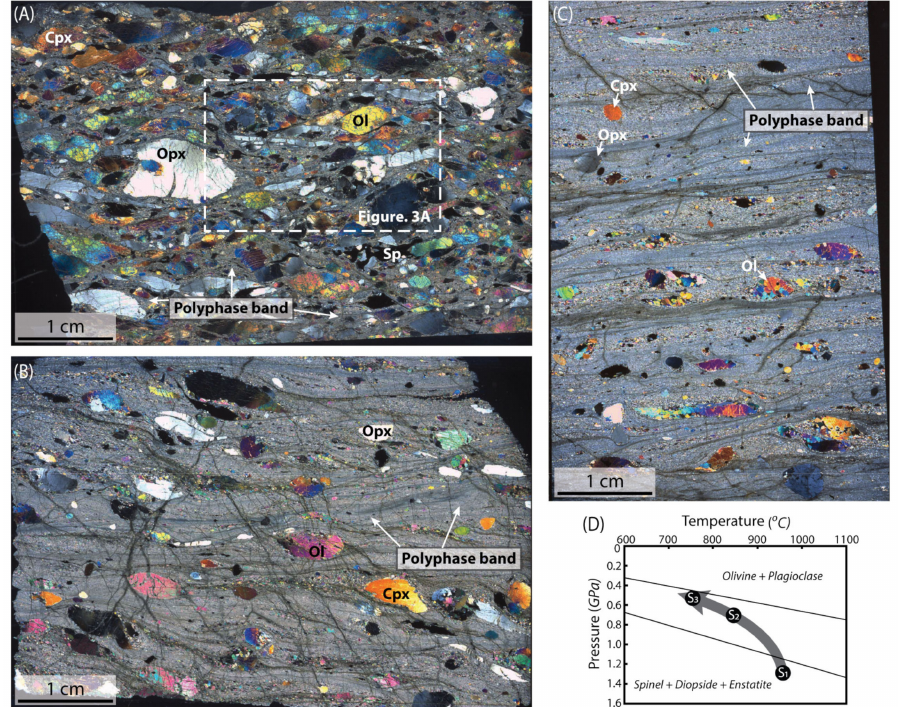
Figure 2. Typical microstructures in the Turon de T é cou è re peridotite. In all photomicrographs lineation is parallel to the top edge and foliation is normal to the photomicrograph. ( A ) Protomylonite 95TT37. ( B ) Mylonite PTT9. ( C ) Ultramylonite PTT1. The white rectangle in A shows the location of the EBSD map in Figure 3A. ( D ) Pressure–temperature conditions of deformation (modified from [12]). Temperatures are based on the compositions of co-existing pyroxenes [78] and olivine + spinel [79]. S1, S2, and S3 correspond to stages 1, 2, and 3 (for more information see text and Figure 8). Ol: olivine; Opx: orthopyroxene; Cpx: clinopyroxene; Sp: